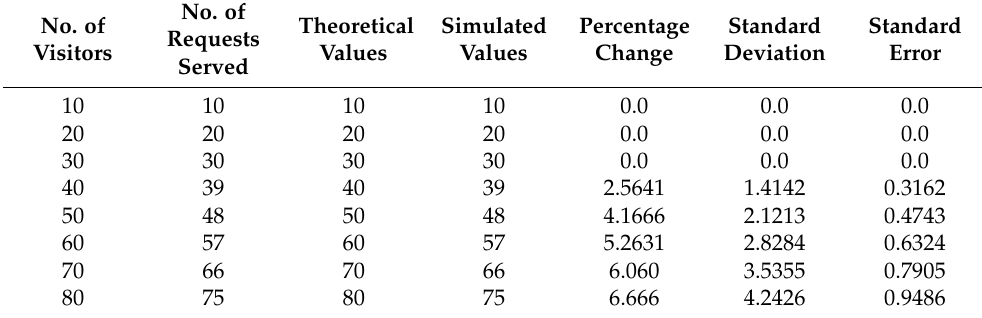
Table 6. Types of users by